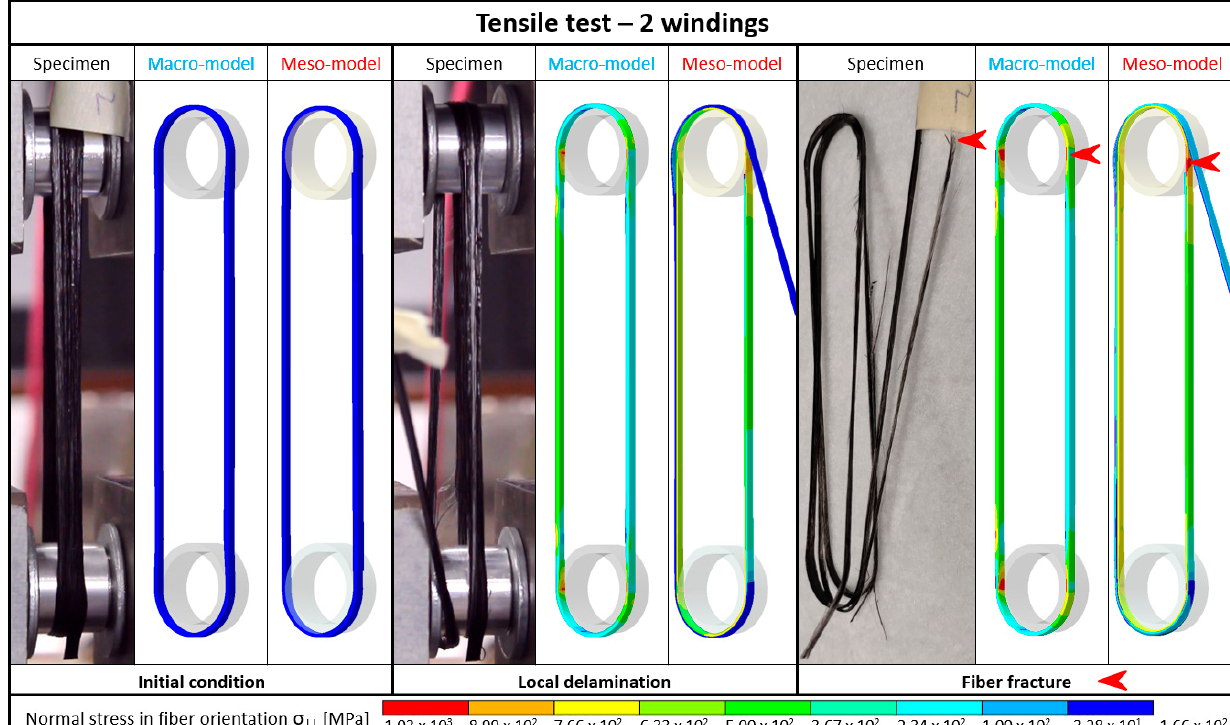
Figure 17. Load-displacement curves from tensile tests on simple loops with two windings (meas- ured and calculated).